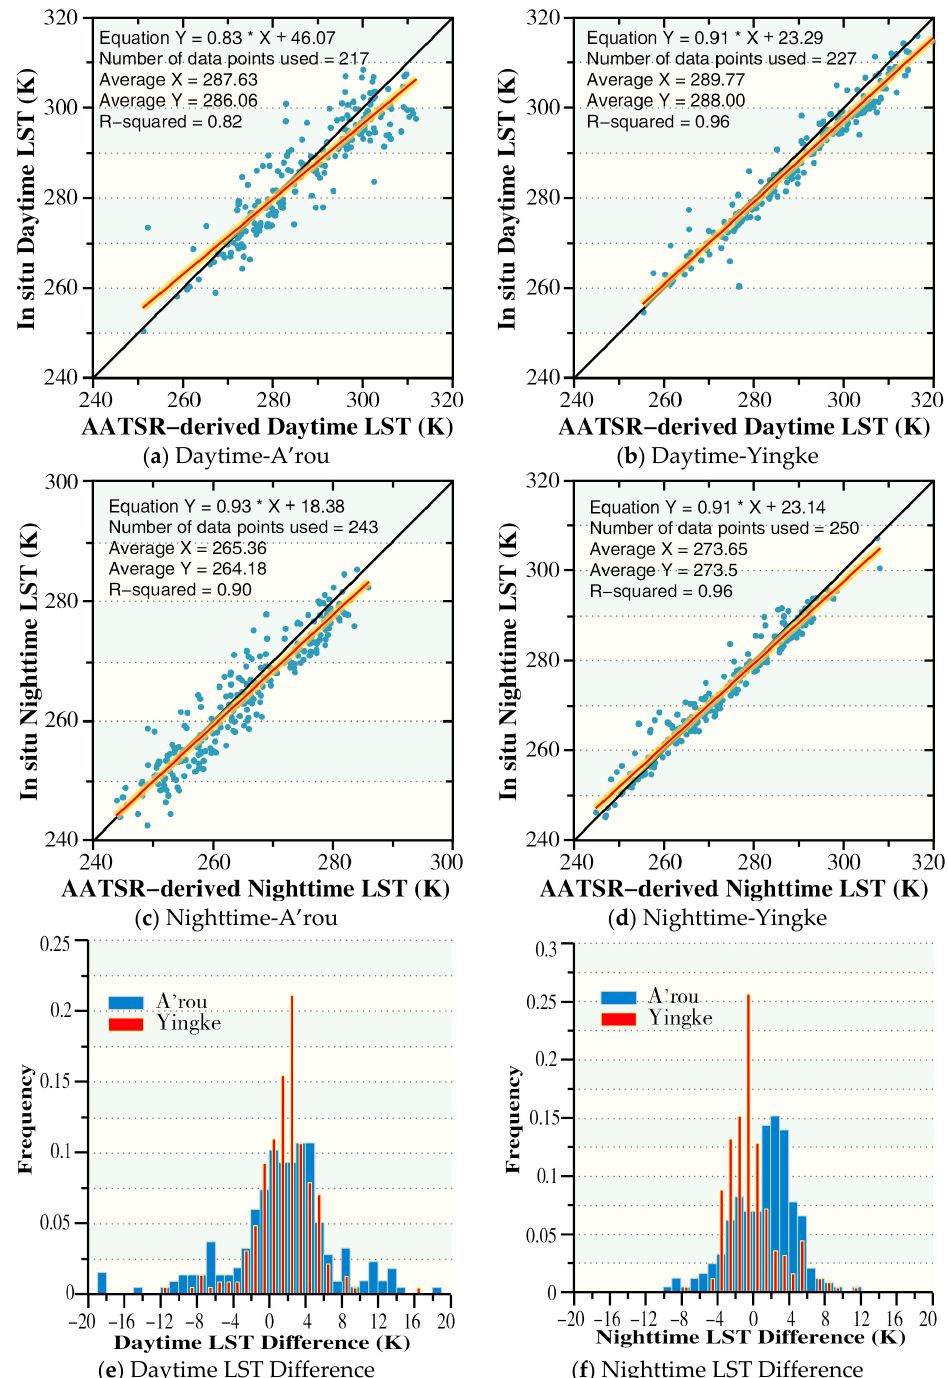
Figure 2. Comparisons between AATSR-derived LST and in situ LST at A’rou and Yingke site for 2007–2011: ( a ) daytime comparison at A’rou site; ( b ) daytime comparison at Yingke site; ( c ) nighttime comparison at A’rou site; ( d ) nighttime comparison at Yingke site; ( e ) daytime LST differences for each site; ( f ) nighttime LST differences for each site.